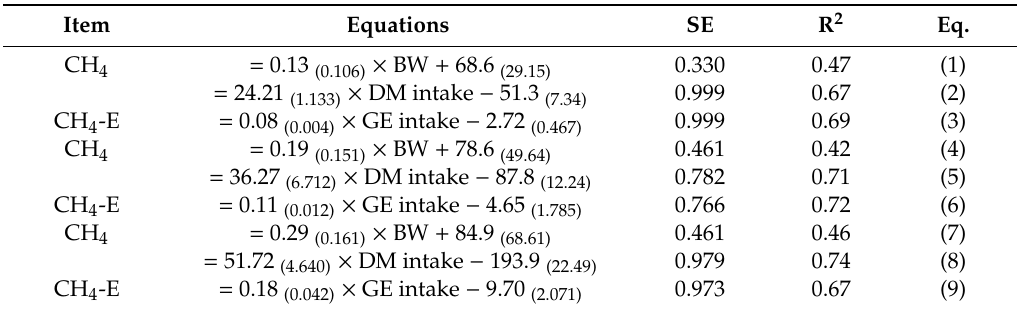
Table 5. Prediction equations of methane (CH 4 ) emission for Holstein heifers at age of 9, 12, and 15